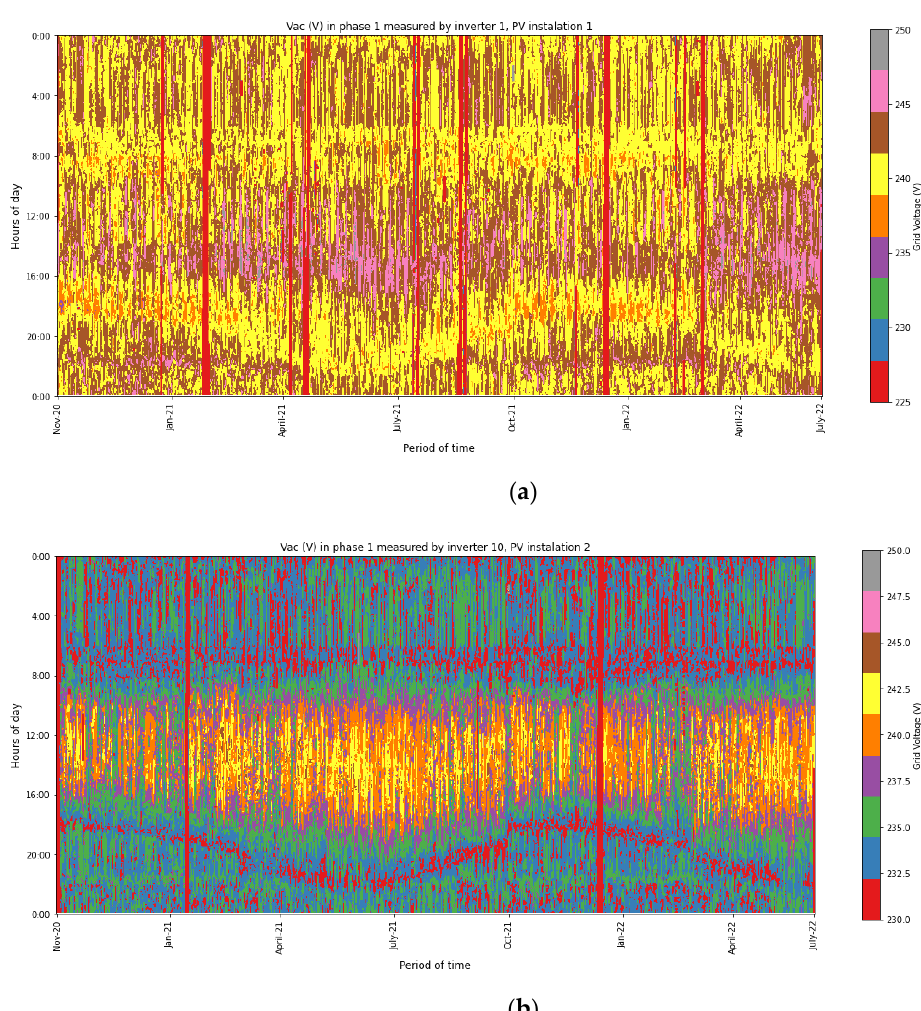
Figure 17. Grid voltage values ( V ac ) measured every 5 min on phase 1 by inverters 1 ( a ) and 10 ( b ) of plants 1 and 2 respectively during the period 1 November 2020 to 4 July 2022.